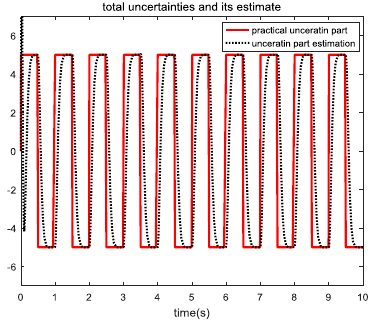
Figure 8. Disturbance signal and ESO’s predictions.